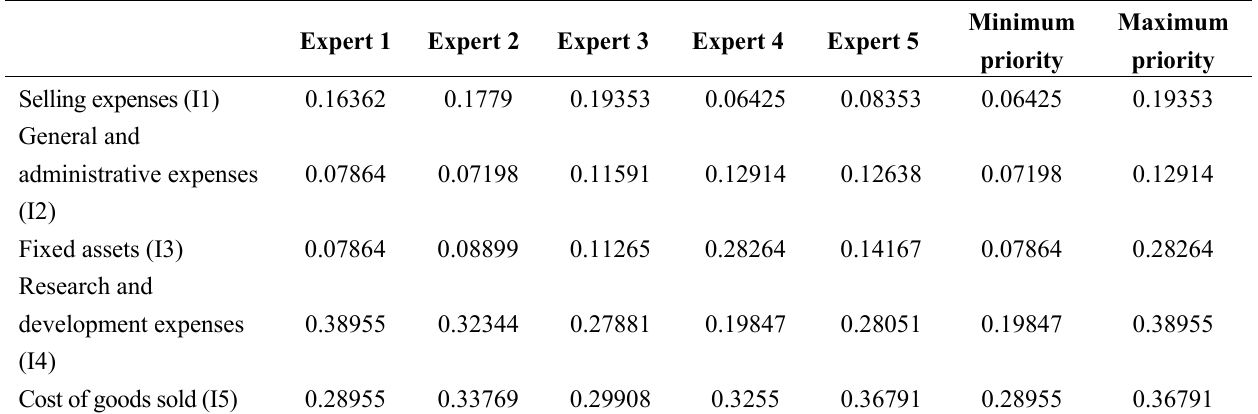
Table 9. Priorities of the inputs by the experts.